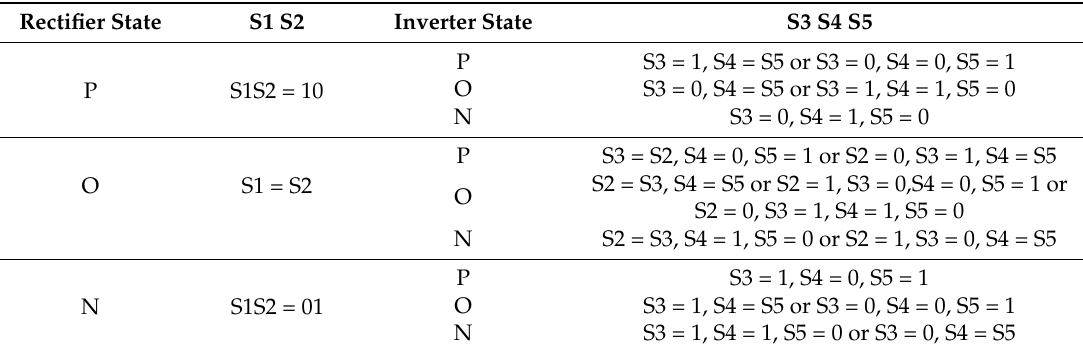
Table 1. Switching states of rectifier side and inverter